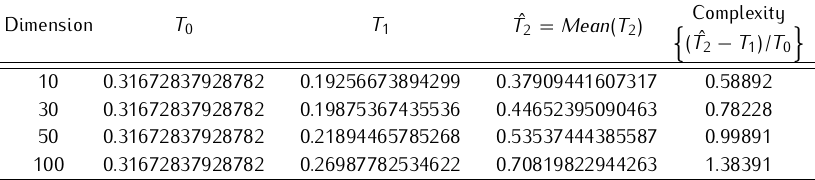
Table 5. Time Complexity of the SCA on Rosenbrock function.